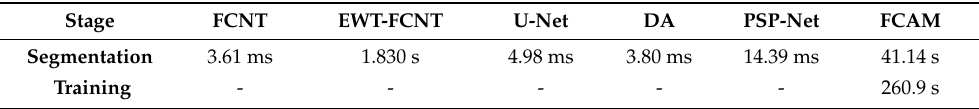
Table 5. Average computation time per image of FCNT, EWT-FCNT, U-Net, DA, PSP-Net, and FCAM on the Prague